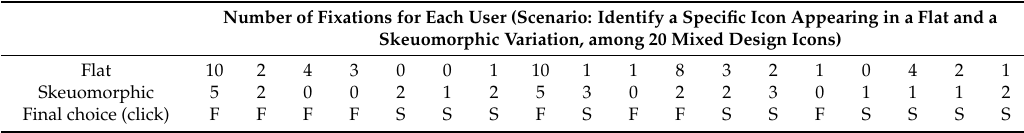
Table 8. Number of fixations on the two icon versions (flat or skeuomorphic) and final choice (F/S) for each user 1 .